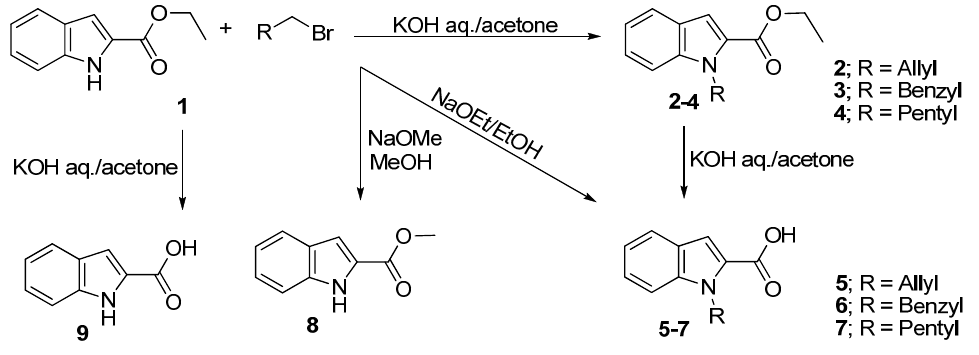
Table 1. Conditions of indole nitrogen alkylation and ester